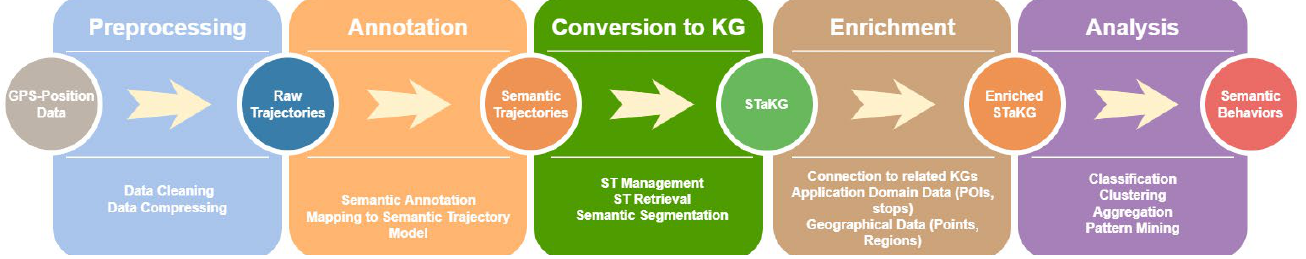
Figure 5. The STaKG pipeline (framework).